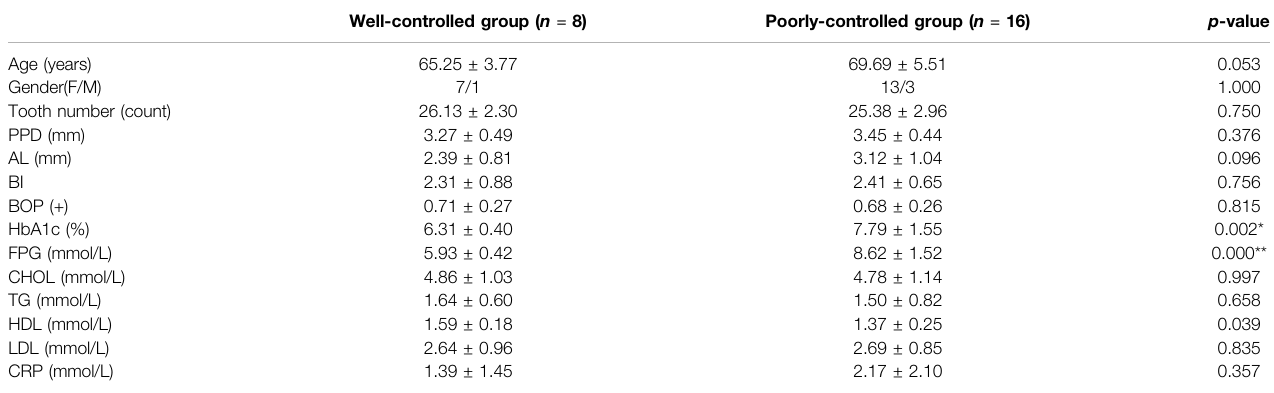
TABLE 1 | Characteristics of participants with T2DM.